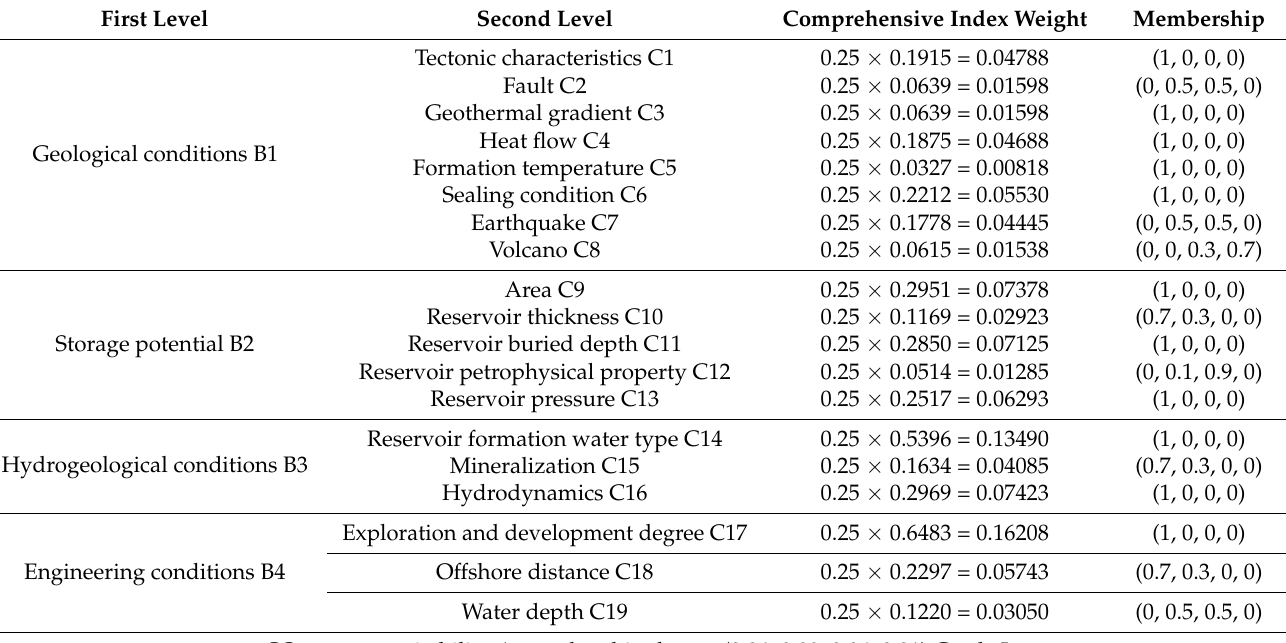
Table 4. Results of CO 2 geological storage suitability evaluation.